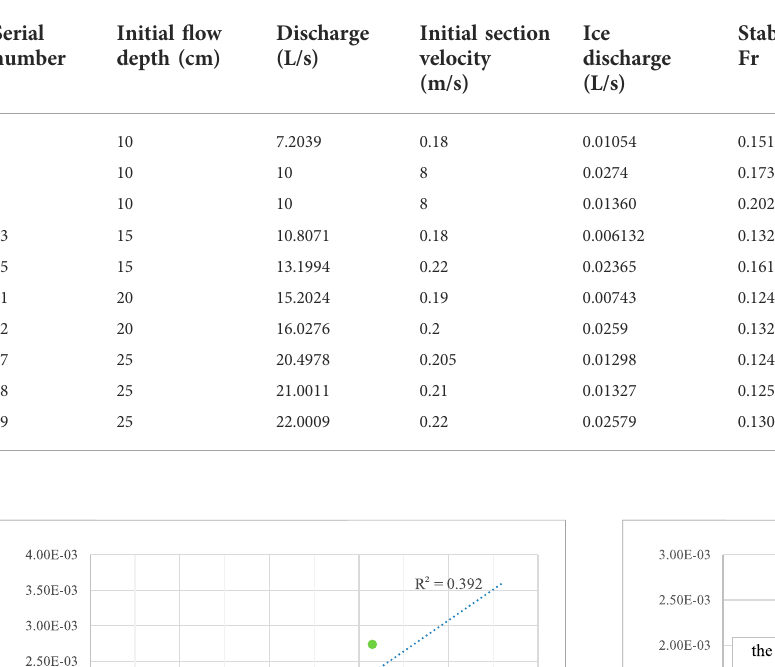
TABLE 2 Results of nine tests.